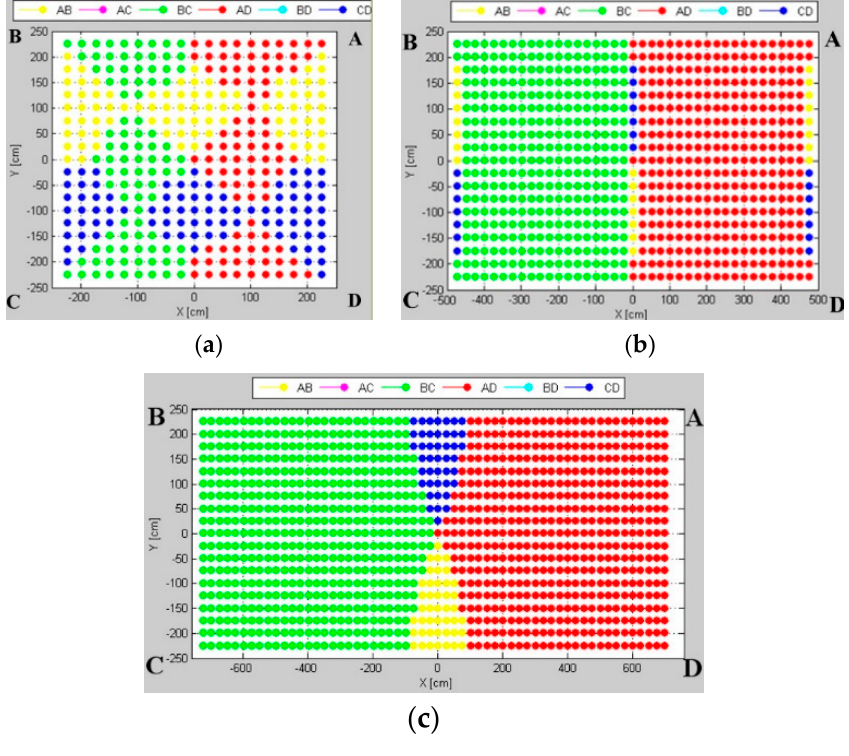
Figure 9. Uncertainty maps for ( a ) test environment TE1; ( b ) test environment TE2; and ( c ) test environment TE3.